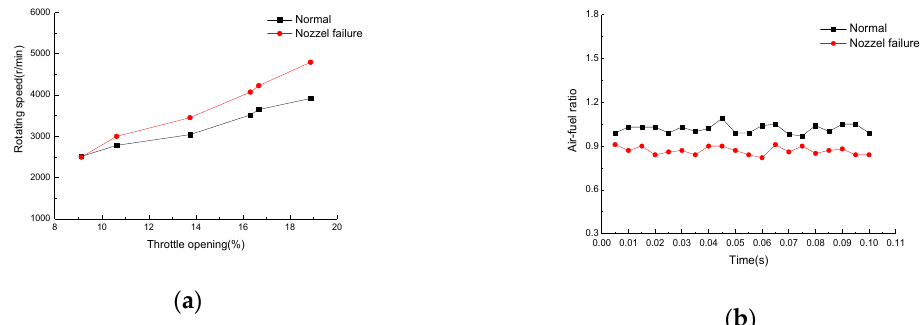
Figure 2. Change chart of speed and air-fuel ratio under normal and nozzle failure conditions. ( a ) Chart of speed variation with throttle opening, ( b ) Chart of transient air-fuel ratio change with different air-fuel ratios.